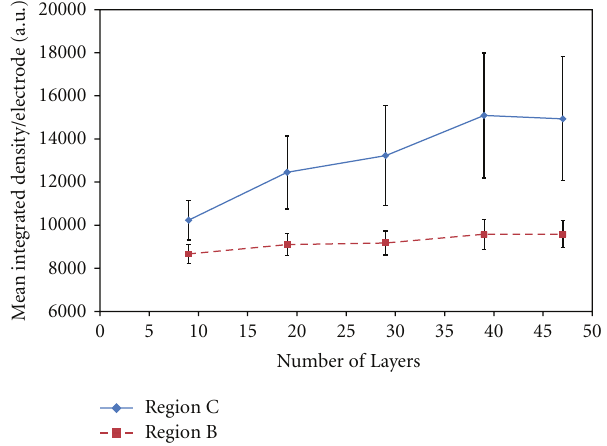
Figure 5: Plot showing the calculated mean integrated density per microelectrode for microelectrodes in regions B and C in bienzyme layer structures of 9, 19, 29, 39, and 47 total layers of 200 nm biotin NPs with alternate enzyme layer addressing of GOx-avidin and